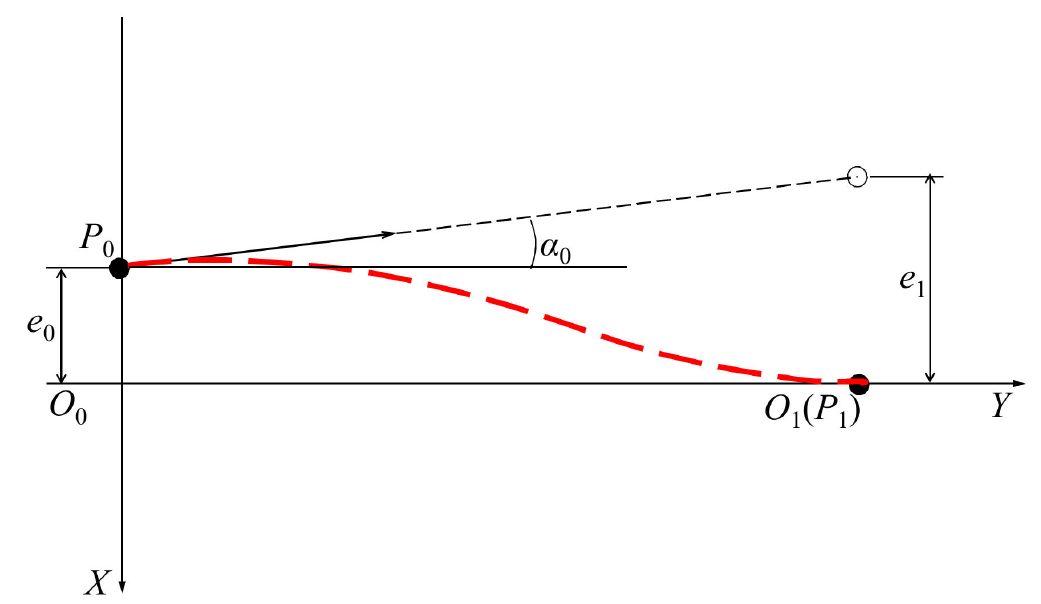
Figure 6. The cubic polynomial path when | e 1 | > | e 0 | and | e 0 | ≤ [ e